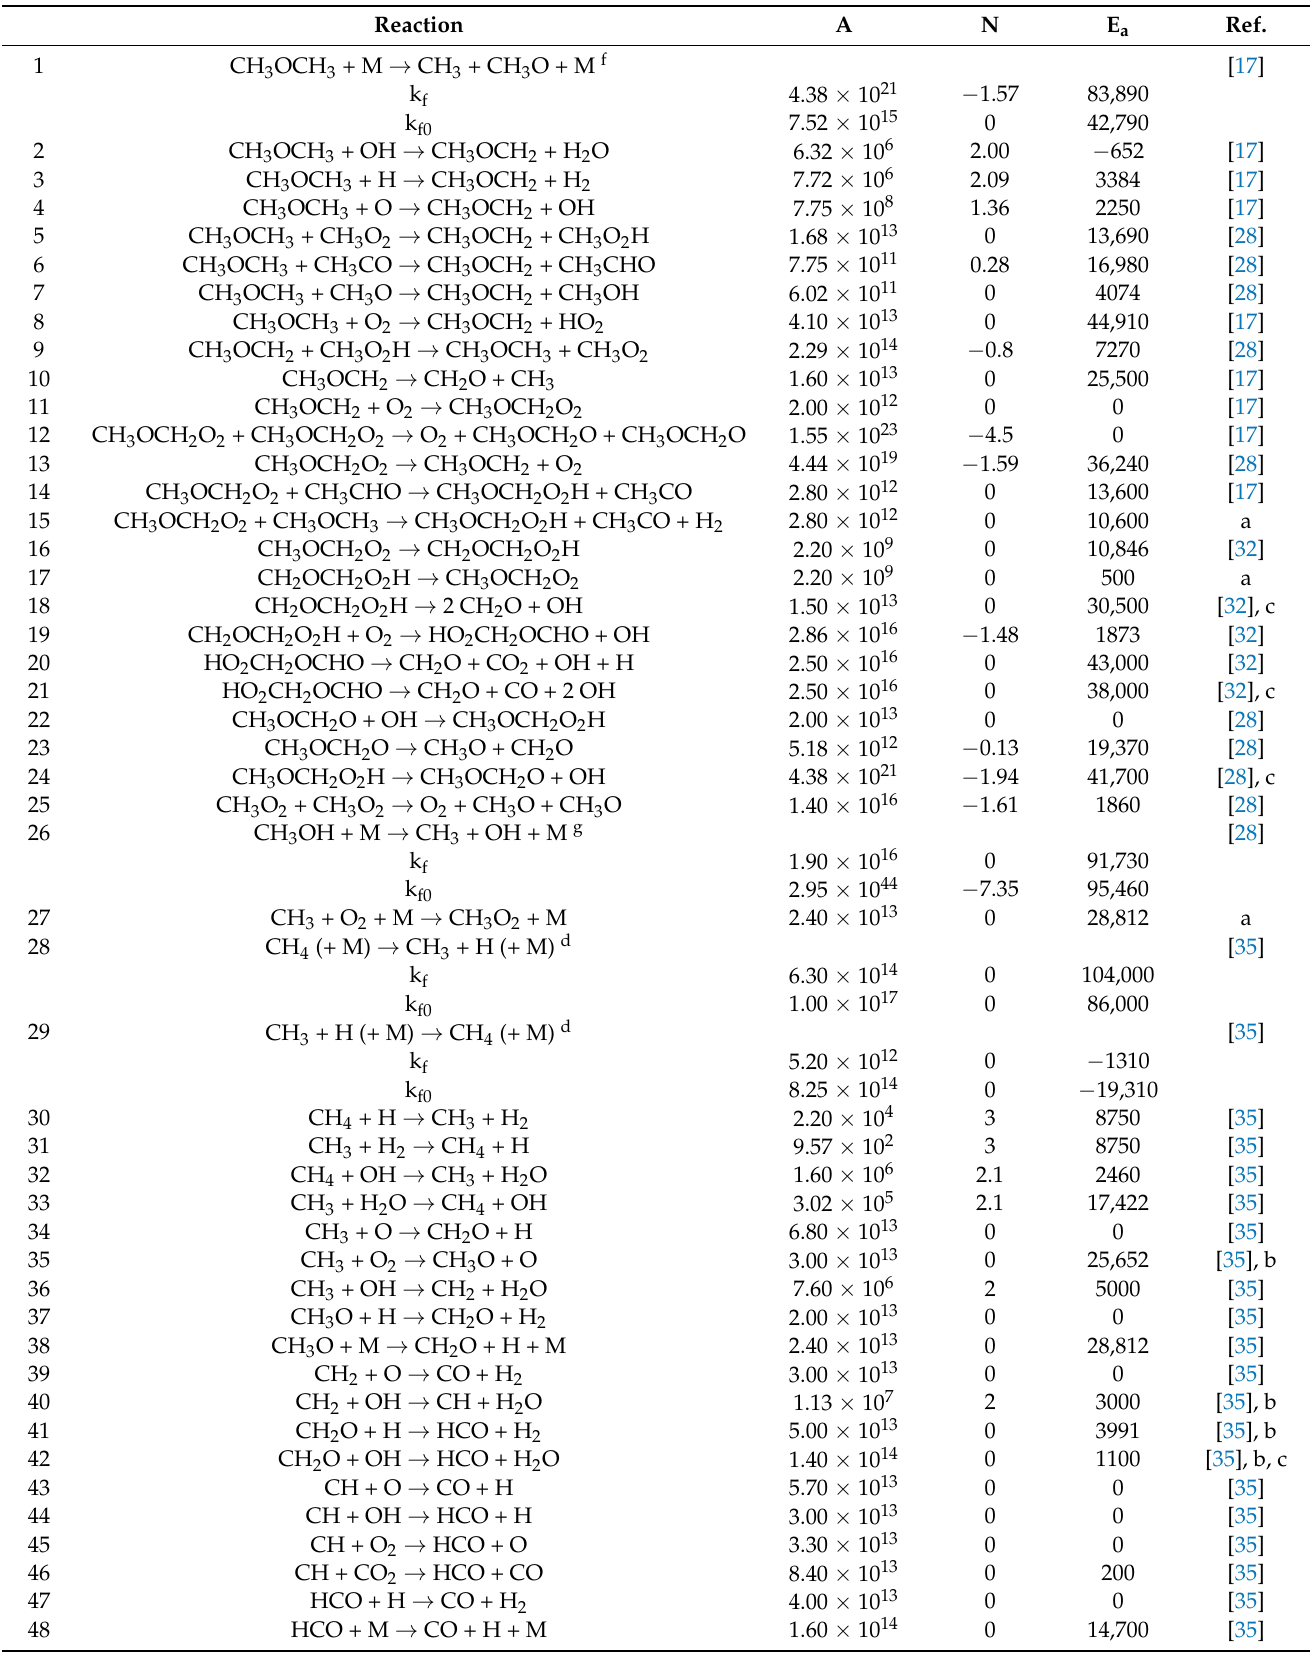
Table 3. The reduced reaction mechanism Z69 (k = A × T n × exp( − E a /RT), units: s, mole, cm 3 , cal, K). Reaction A N E a